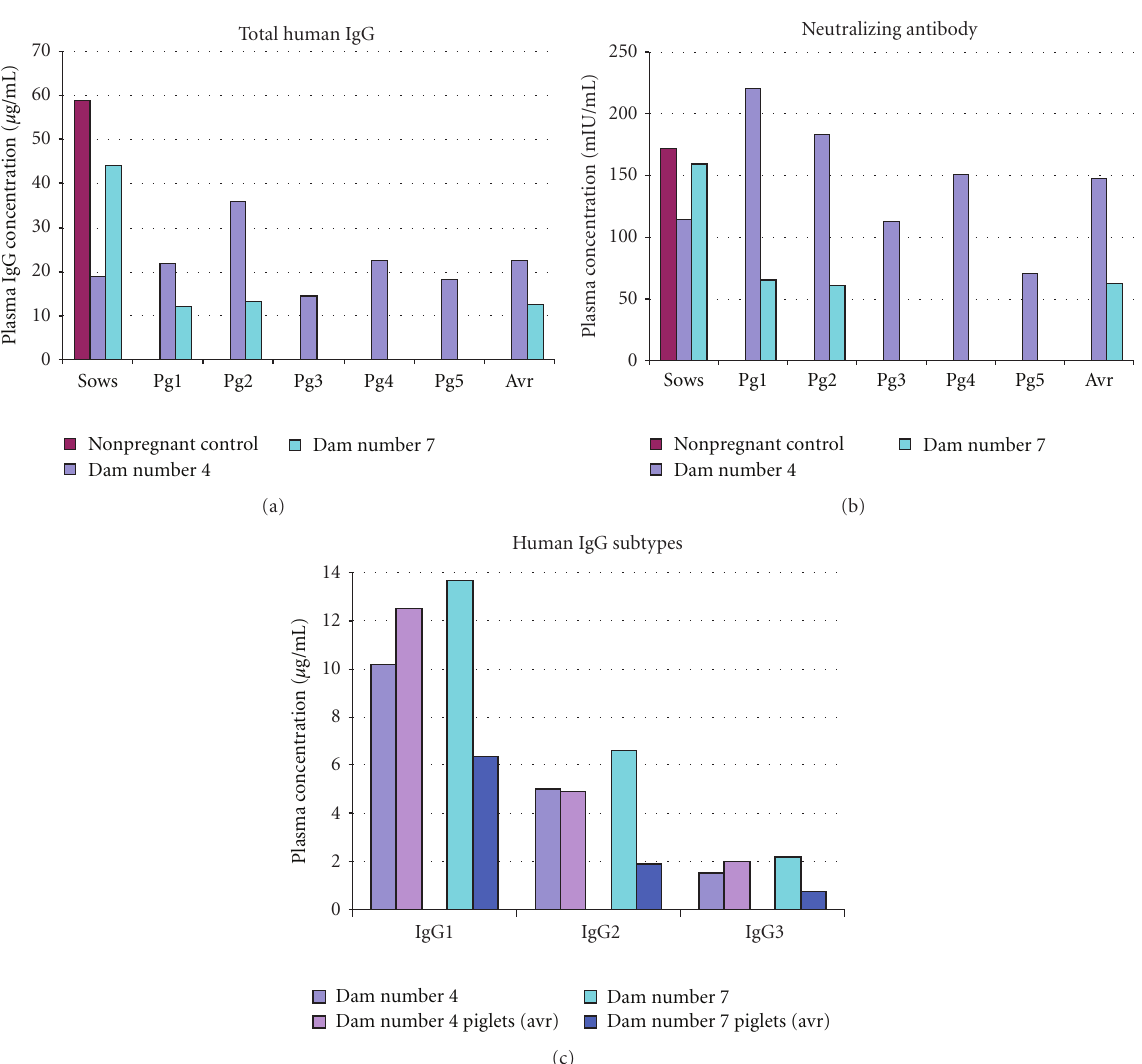
Figure 1: Human IgG transfer to the piglets of pregnant guinea pigs injected with a human immune globulin preparation. Two pregnant sows, numbered 4 and 7, were injected with HBIGIV on days 62 and 66 of pregnancy, respectively. Total and neutralizing human IgG, and the IgG subclasses ((a), (b), and (c), resp.) in the serum of the dams and the piglets (Pg1–5 and Pg1-2, resp.) soon after farrowing (on days 67 and 68, resp.) was quantified with commercial kits. All the piglets had human IgG in their blood stream. The concentrations for total (a) and neutralizing (b) antibody as well as for all the subtypes (c) were higher in the progeny of dam number 4, which delivered five days